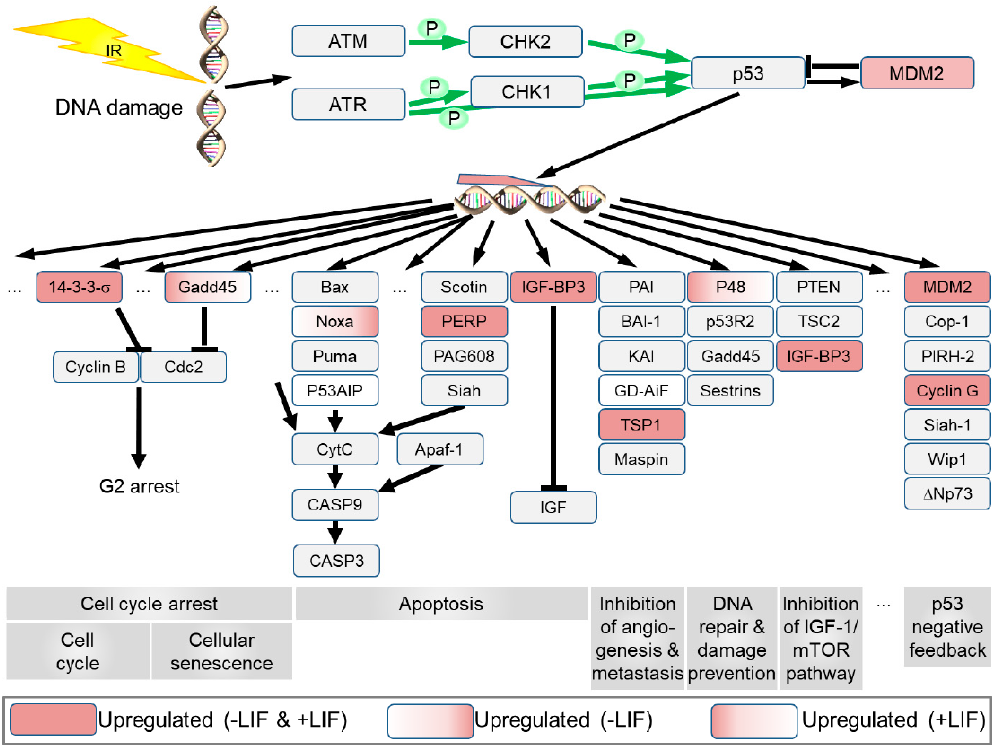
Figure 12. Influence of X-rays (7 Gy) on regulation of the p53 pathway (according to the Mus musculus p53 signaling pathway available at https://www.genome.jp/kegg/ [33] ) in mESCs in presence of LIF (+LIF) and absence of LIF (-LIF). Upregulated genes are highlighted in red. IR, ionizing radiation; …, genes not shown; genes in white boxes are not yet established in mice.